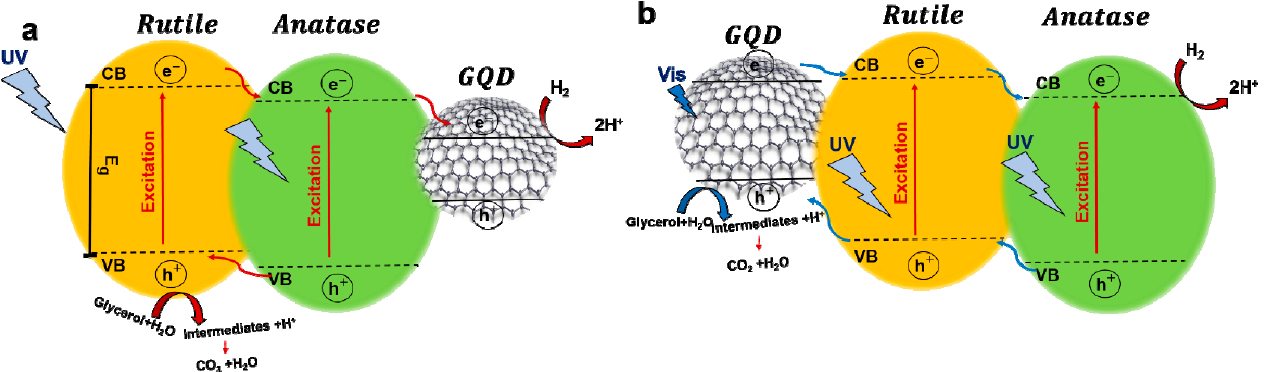
Figure 3. Role of graphene as ( a ) a cocatalyst and ( b ) a sensitizer in TiO 2 /GQDs for improved photocatalytic H 2 evolution under solar light irradiation (Adapted from [98]. Reprinted with permission from [98] Copyright 2020 American Chemical Society).